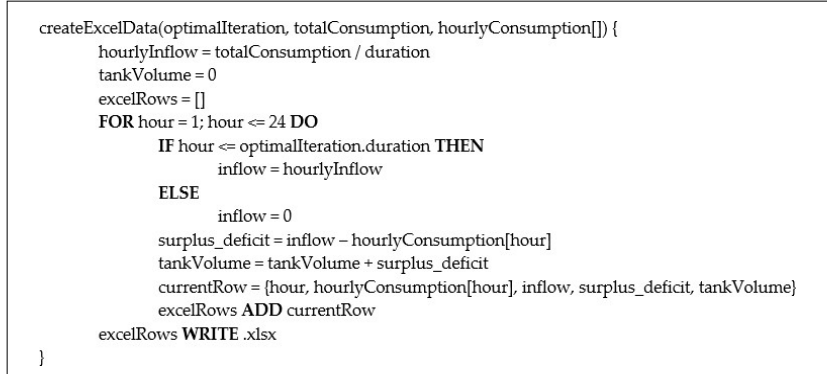
Figure 3. Pseudocode 2—creating an Excel file.